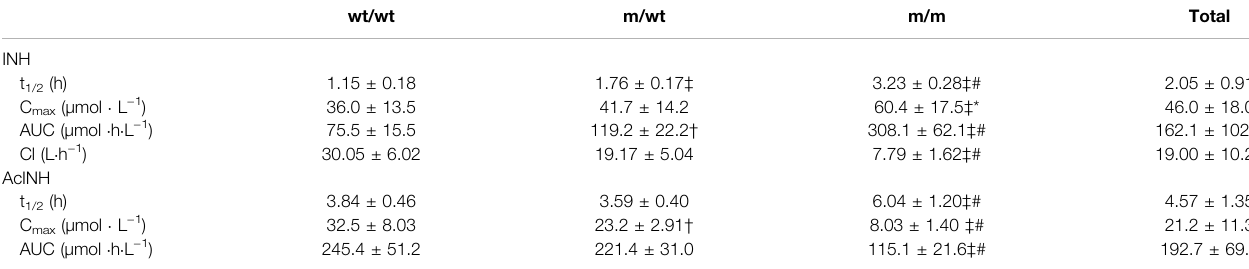
TABLE 2 | Pharmacokinetic parameters of INH and AcINH in Chinese healthy subjects with different NAT2 genotypes. wt/wt